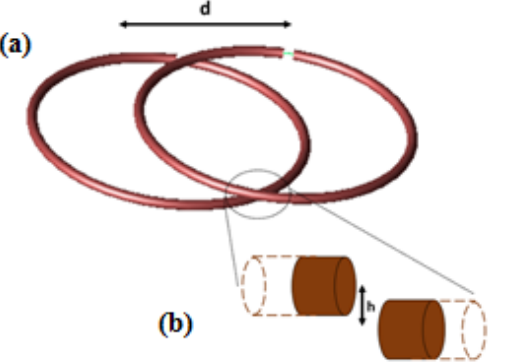
Figure 6. Two-element array (Coil #6): ( a ) CAD model for FDTD simulation; ( b ) zoom of the loop planes